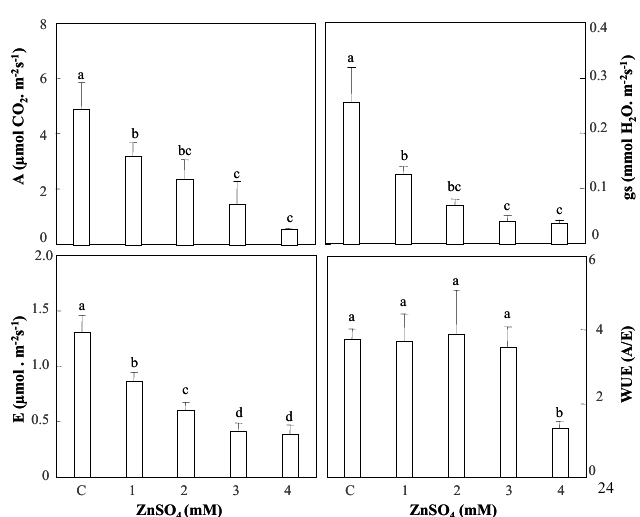
Fig. 3: CO 2 assimilation rate (A), stomatal conductance (B), transpiration rate (C) and water use efficiency (D) of fenugreek plants grown with different ZnSO 4 concentrations for 52 days. Values (means ± SE of five replicates) followed by the same letter are not significantly dif - ferent (Duncan test, P = 0.05).